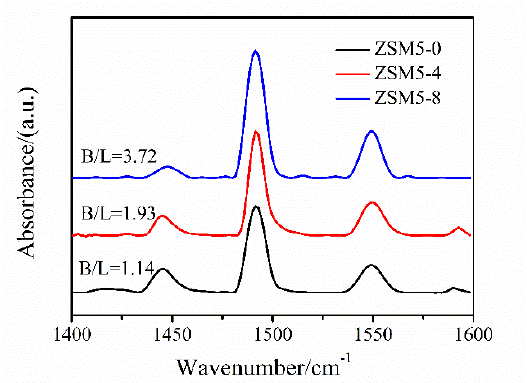
Figure 8. Pyridine-absorbed FTIR spectra of ZSM-5 synthesized with different ethanol concentrations.